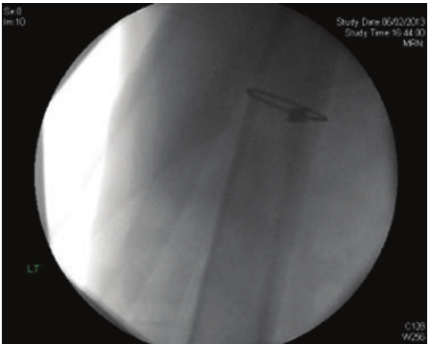
Figure 3: Intraoperative Image Intensifier image of femoral dia- physis after removal of Revitan femoral component, showing no evidence of fracture or loss of bone stock.